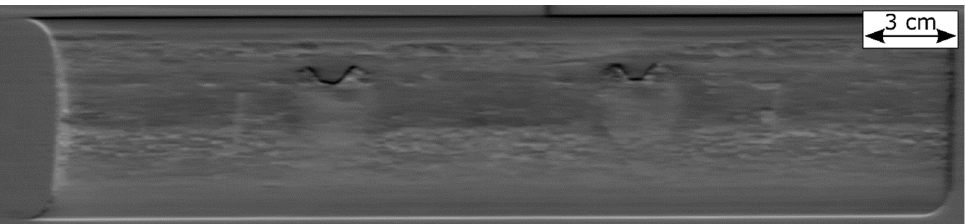
Figure 19. Measurement with µ-bolometer camera and increased frame rate (200 Hz) with a scanning speed of 150 mm/s.